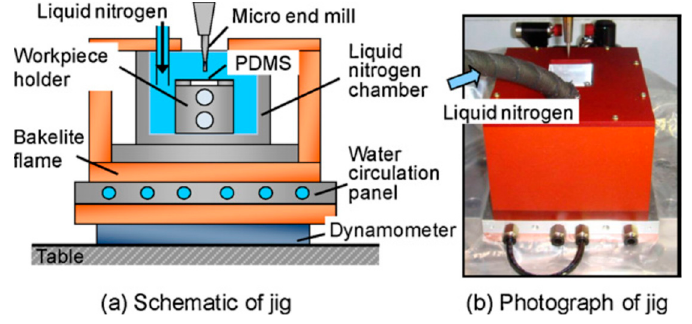
Figure 2. Jig for cryogenic micromachining [46].